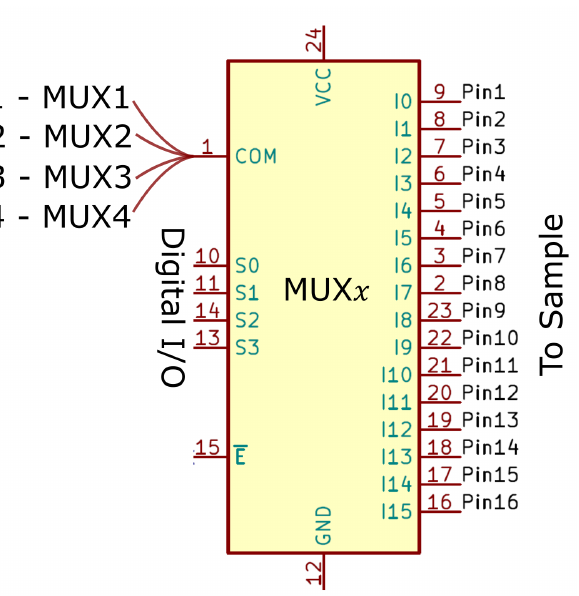
Figure 5. Multiplexer wiring diagram for ConcrEITS. Four multiplexers are used to switch the 4- probe signals over any combination of the 16 electrodes, as in Figure 2b. Each multiplexer is switched using 4 digital outputs from the